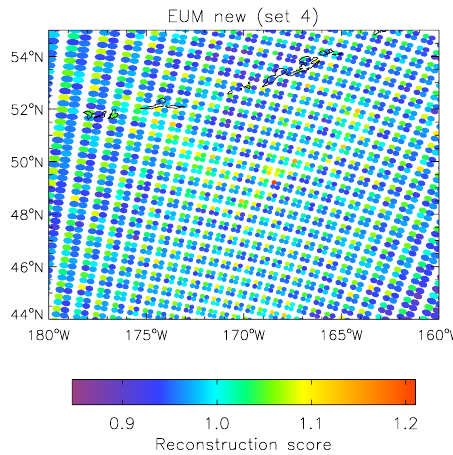
Fig. 14. Band 2 reconstruction scores for the Kasatochi eruption, using the set 4 eigenvectors. To be compared with Fig.